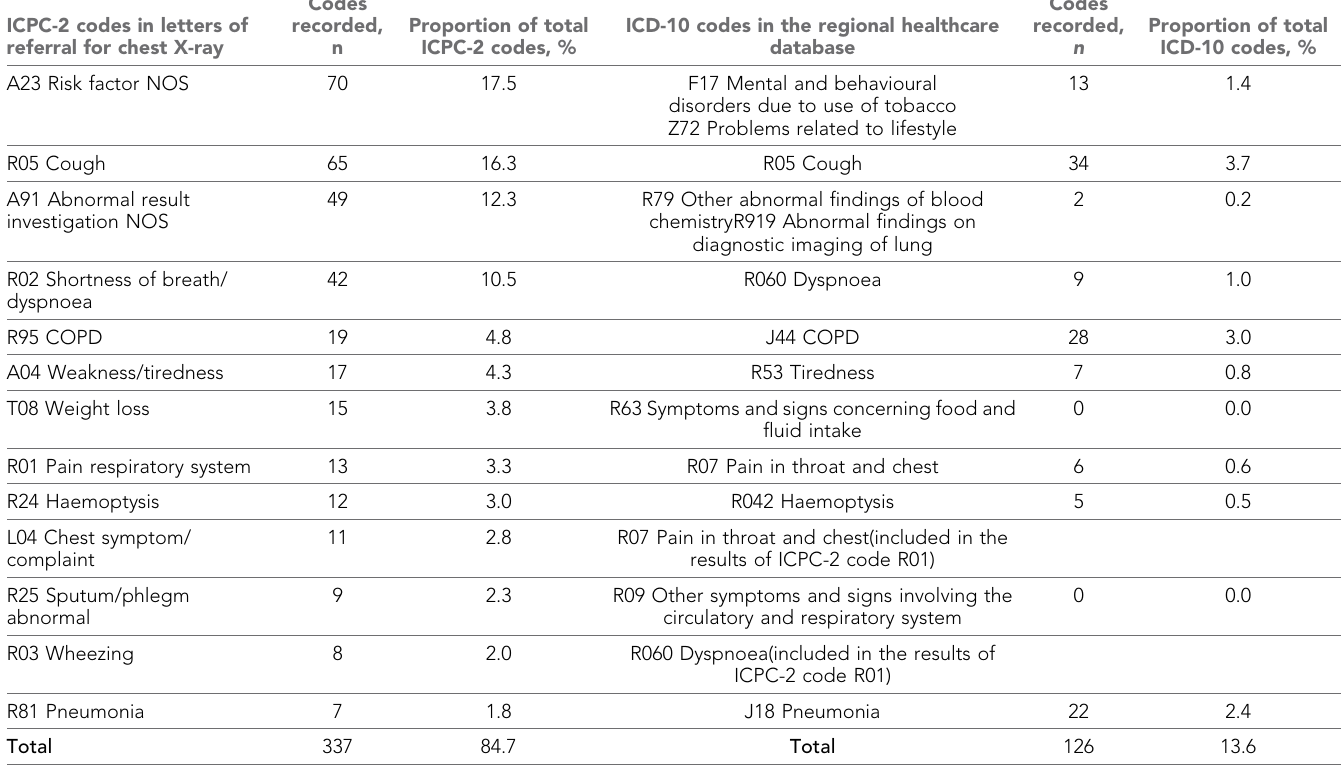
Table 4. ICPC-2 codes a in letters of referral for chest X-ray compared with corresponding ICD-10 codes in the regional healthcare database ICPC-2 codes in letters of referral for chest